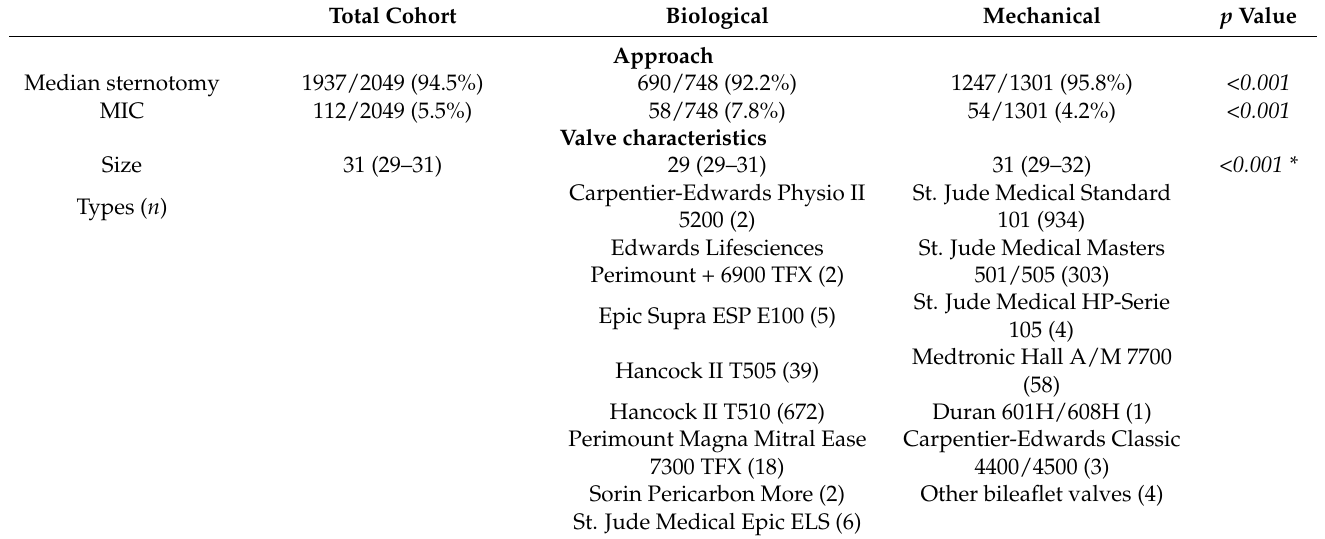
Table 2. Intraoperative characteristics.